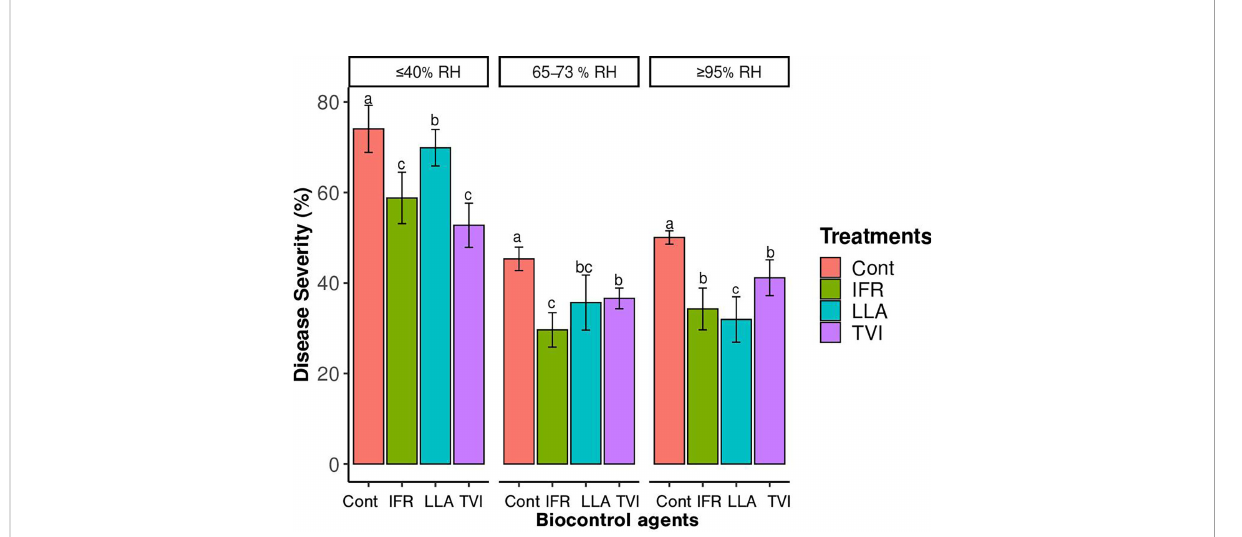
FIGURE 3 The disease severity (DS) curves for powdery mildew development on cucumber plants when treated with Lecanicillium attenuatum (LLA), Trichoderma virens (TVI), and Isaria fumosorosea (IFR), and untreated control (Cont). The data represent the disease severity (%) for each week ’ s treatment under the designed relative humidity conditions, ≥ 95% RH, 65-73% RH, and ≤ 40% RH. All the leaves in the treatments were pretreated 72 hours before inoculating P. xanthii. The vertical bars are the mean ± SE (n = 6). The letters indicate that values are signi fi cantly different at P< 0.05 according to the Least Signi fi cance Difference